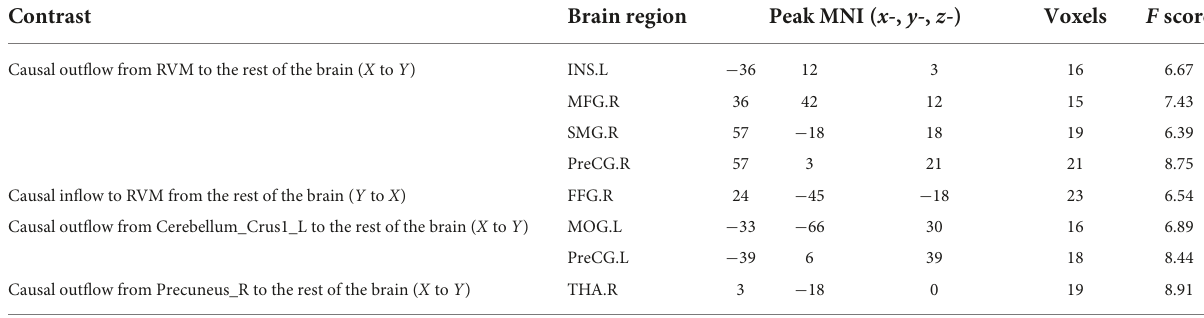
TABLE 4 The DEC variability significantly during the different periods of